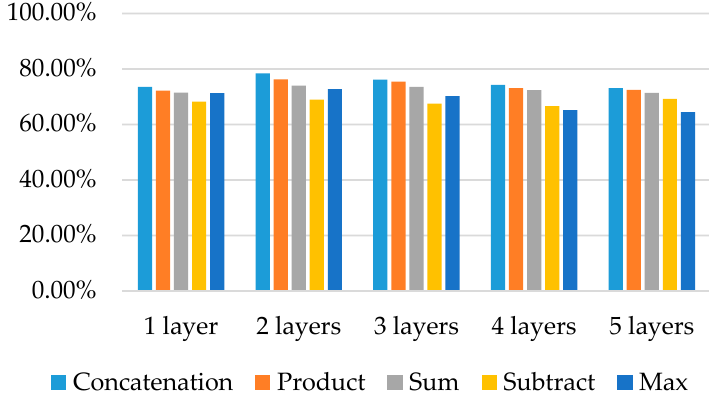
Figure 4. Performance comparison of five kinds of fusion strategies and five kinds of depth of local network.